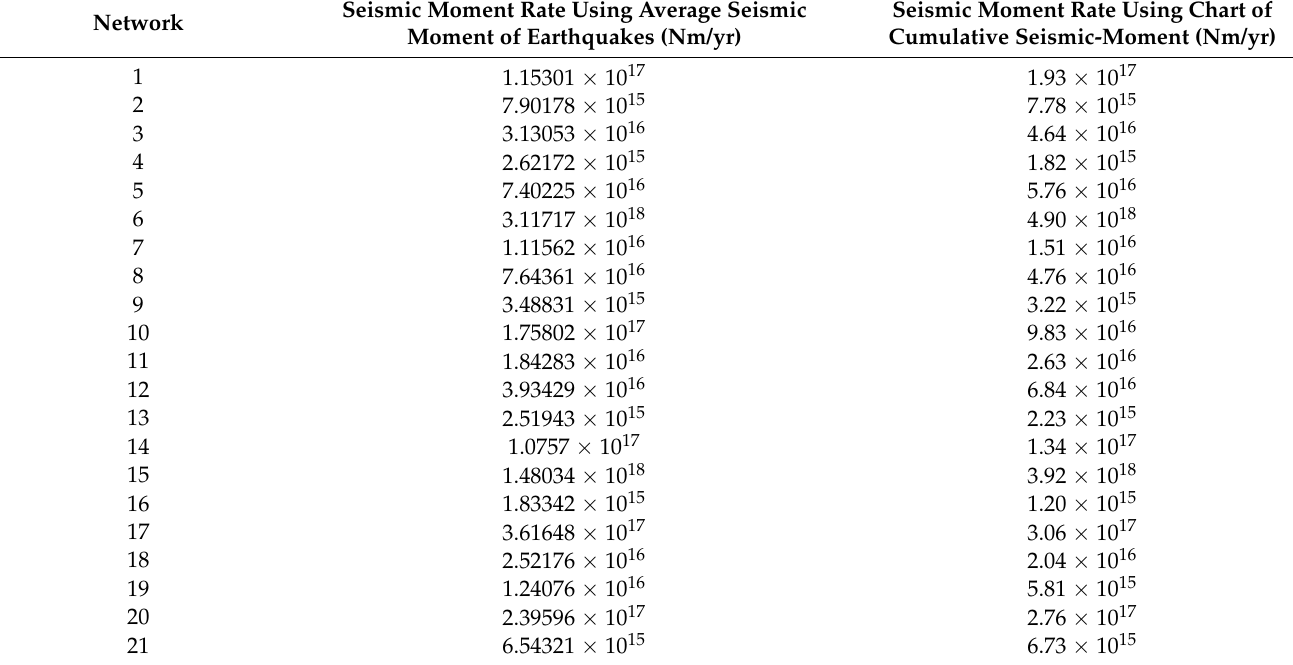
Table 10. The seismic moment rate for each networks in the